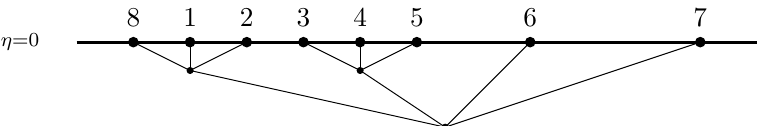
Figure 15 . Eight point Witten diagram associated to the non-ladder graph A ( I 8 : 16 , 28 , 35 , 47) .